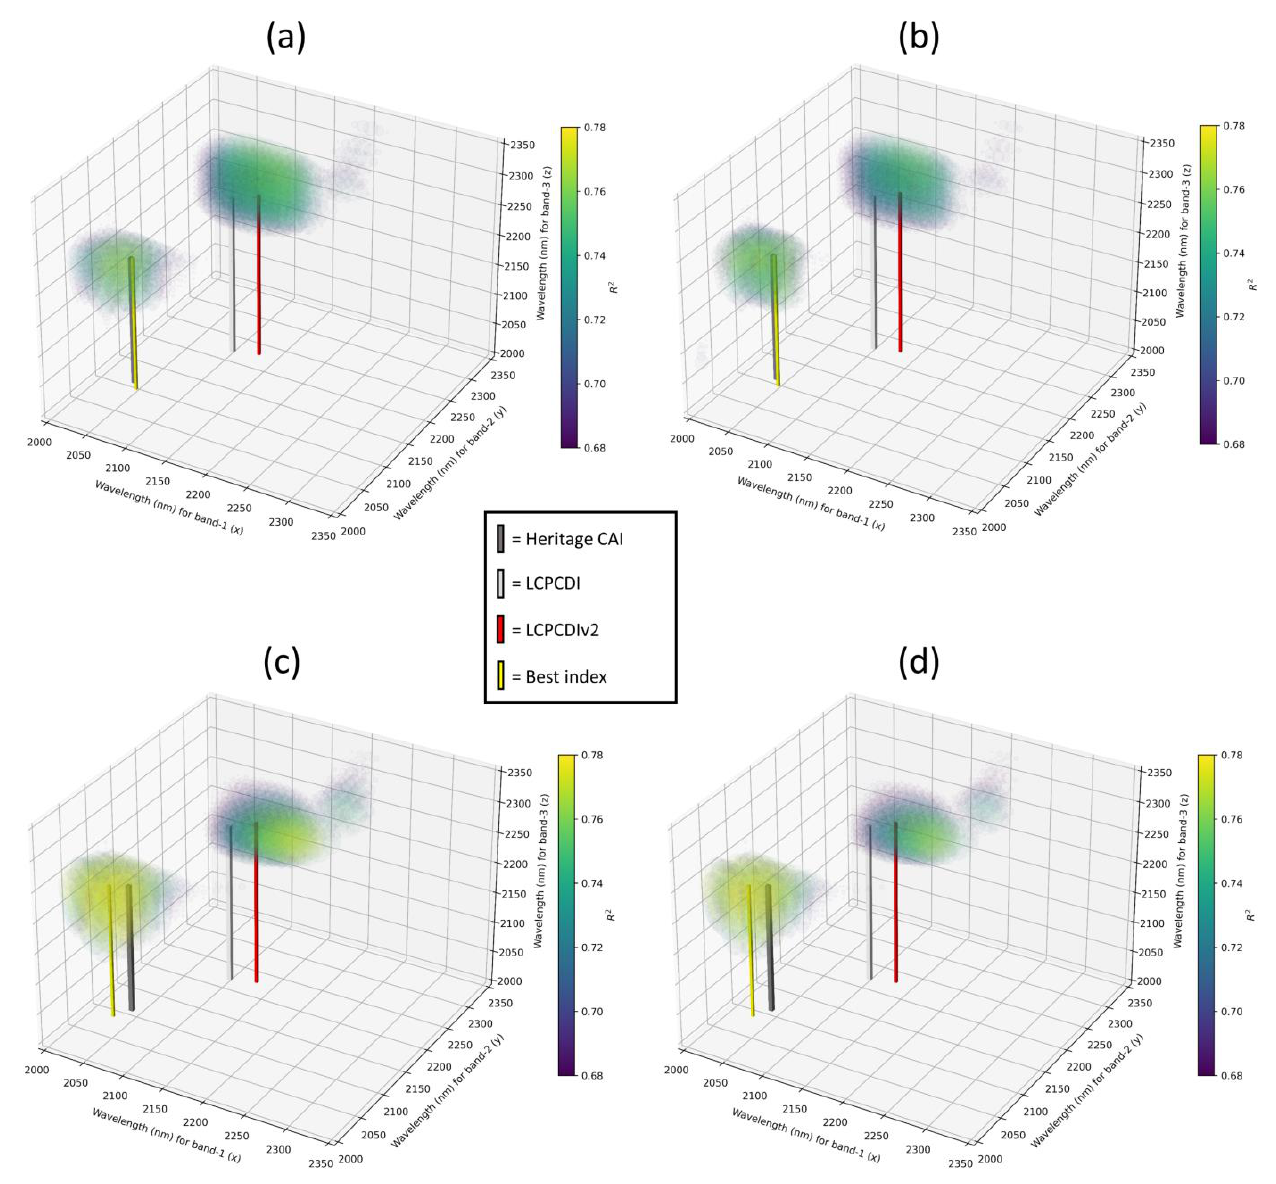
Figure 6. Three-band wavelength shift analysis f R estimation results for the 10 nm dataset with